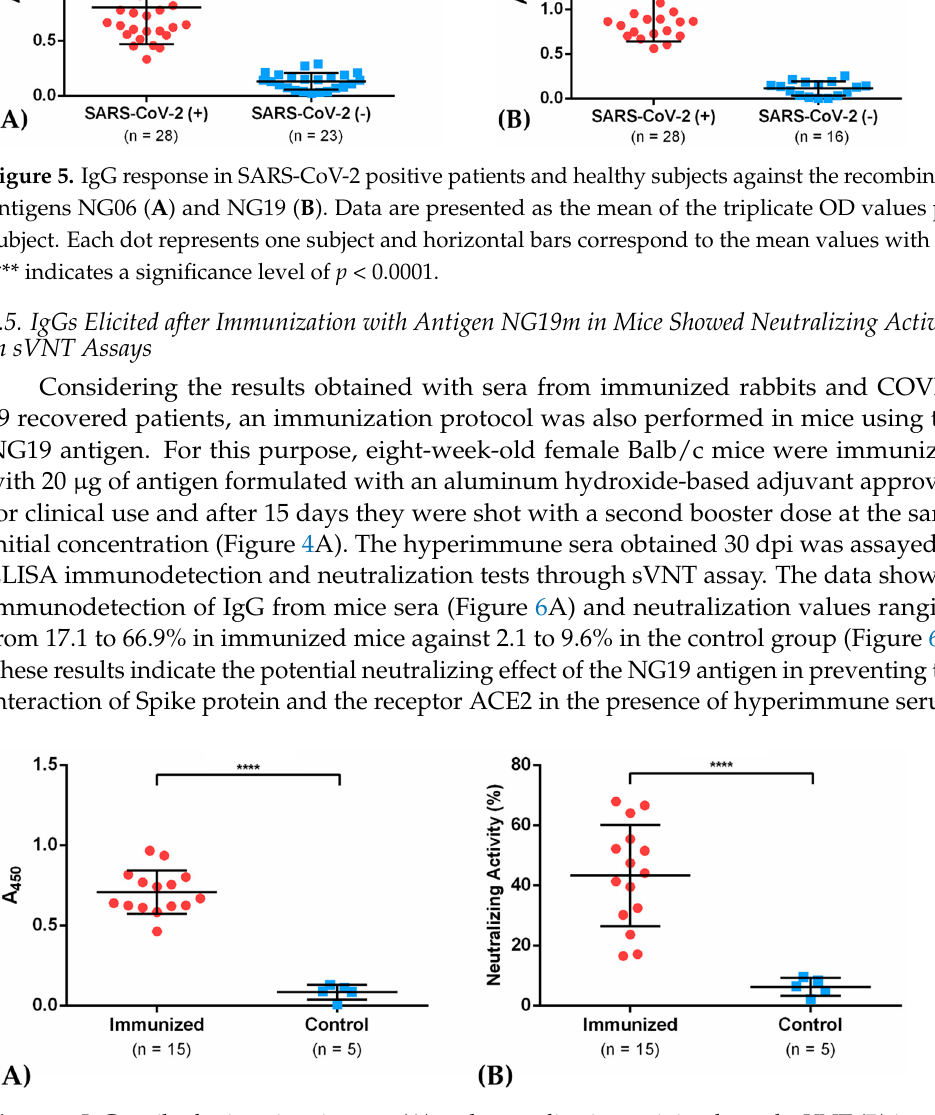
Figure 4. NG06 and NG19 proteins elicit immune responses. ( A ) Scheme of animal immunization with recombinant antigens. ( B , C ) Indirect ELISA titration of pre–immune and hyperimmune rabbit